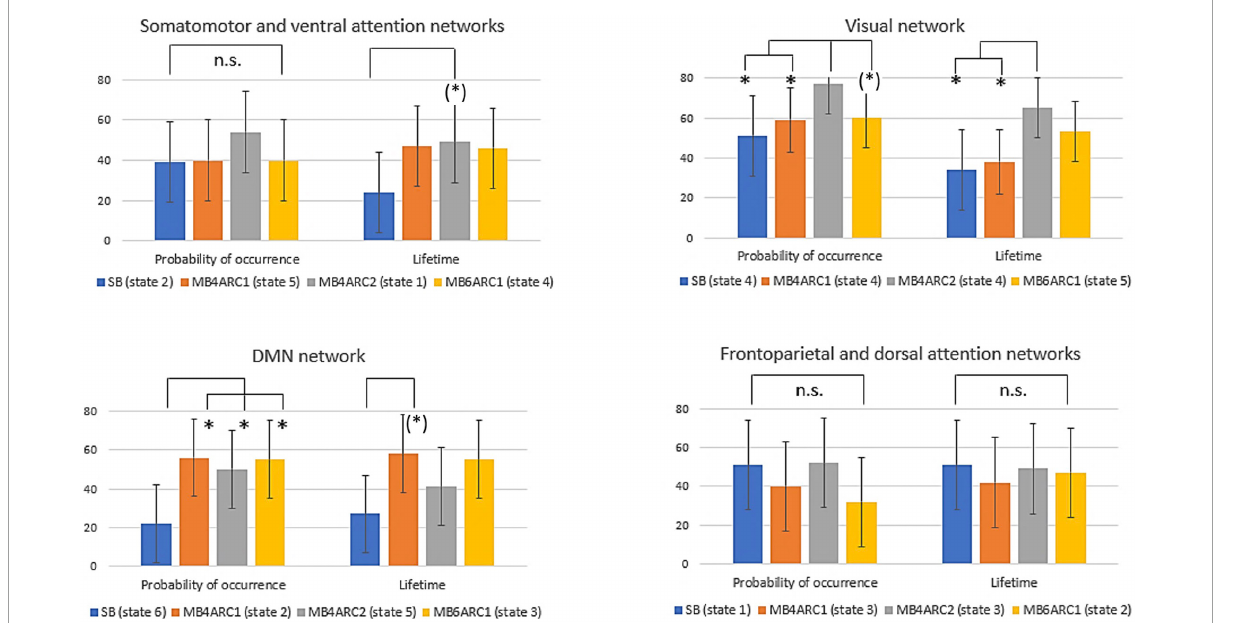
FIGURE4 Formal comparison of the ICC scores and associated confidence intervals for the probability of occurrence and lifetime measures across all four rs-fMRI modalities. n.s., non-significant; ( ∗ ), significant F -test, FDR-uncorrected (did not survive FDR correction); ∗ , significant F -test, FDR- corrected (survived FDR